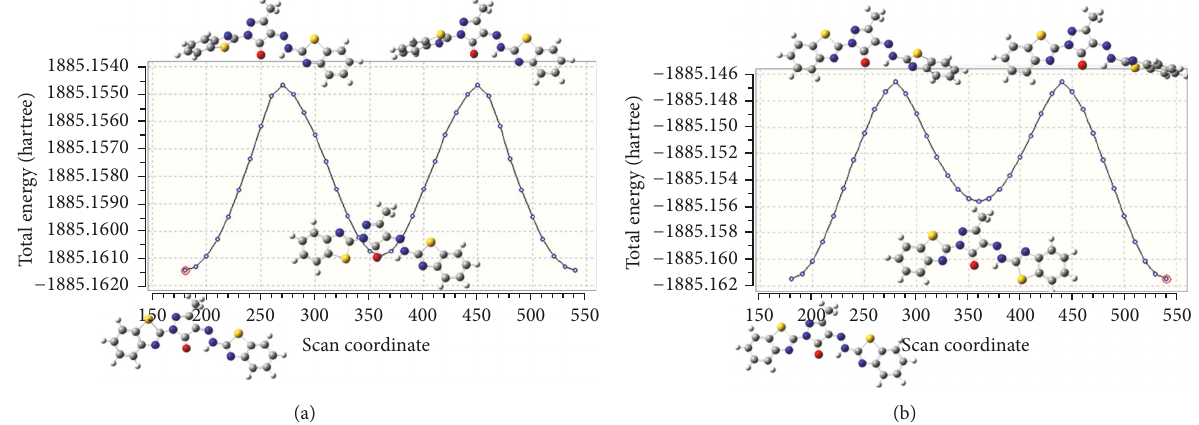
Figure 3: (a) Scanning graph of the dye 3a on dihedral angle (S24–C7–N22–C13). (b) Scanning graph of the dye 3a on dihedral angle